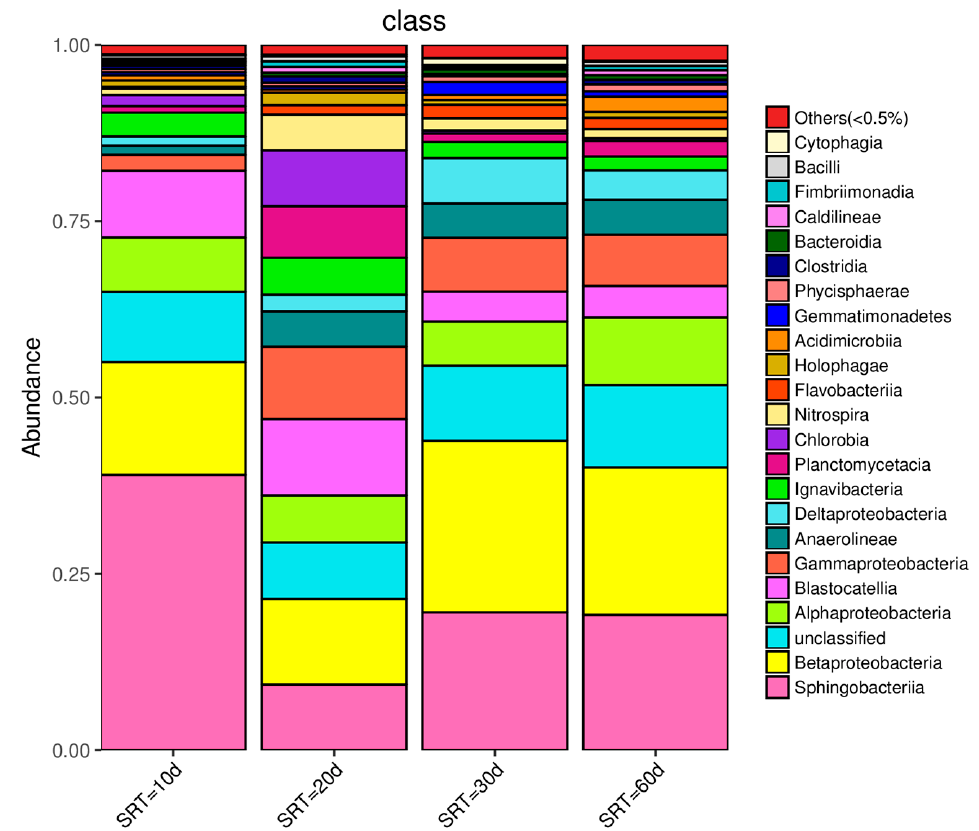
Figure 4. Microbial community structure in activated sludge under different SRT conditions.